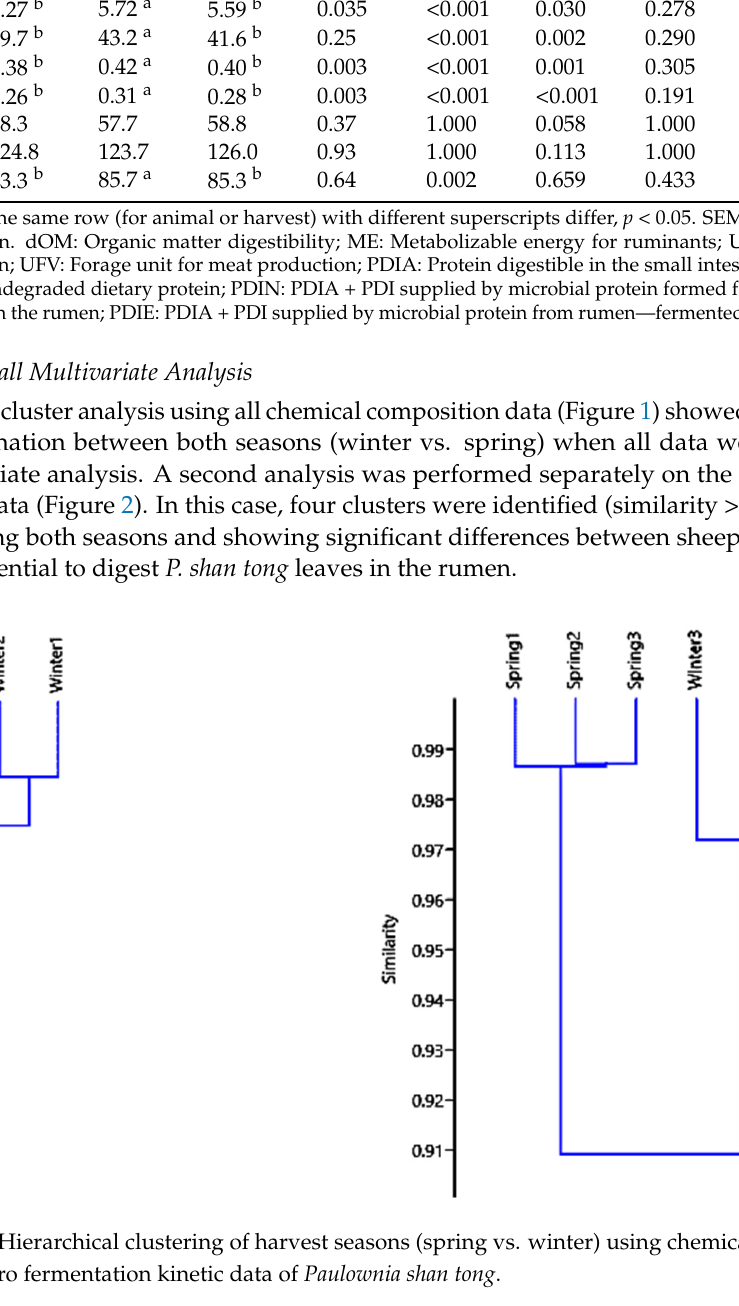
Table 4. In vitro organic matter digestibility, metabolizable energy for ruminants, and microbial protein supply of Paulownia shan tong . Animal Species Harvest Season p Value Goat Sheep Animal × Harvest